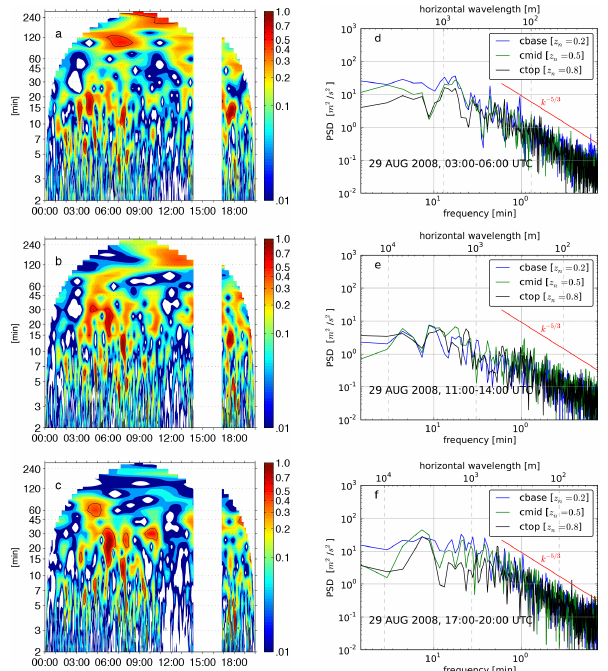
Fig. 9. Same as in Fig. 7, but for 00:00–20:00UTC on 29 August. Data between 14:15 and 16:50UTC are masked as there were two low-level clouds below 2.5km during this time range. The right pan- els show the absolute (non-frequency scaled) power spectral density (PSD) of cloud-level (colors) w [m 2 s − 2 ] as a function of frequency (lower axis [min]) and effective horizontal wavelength (upper axis [m]) for subsets of the case period: (d) 03:00–06:00, (e) 11:00– 14:00 and (f)